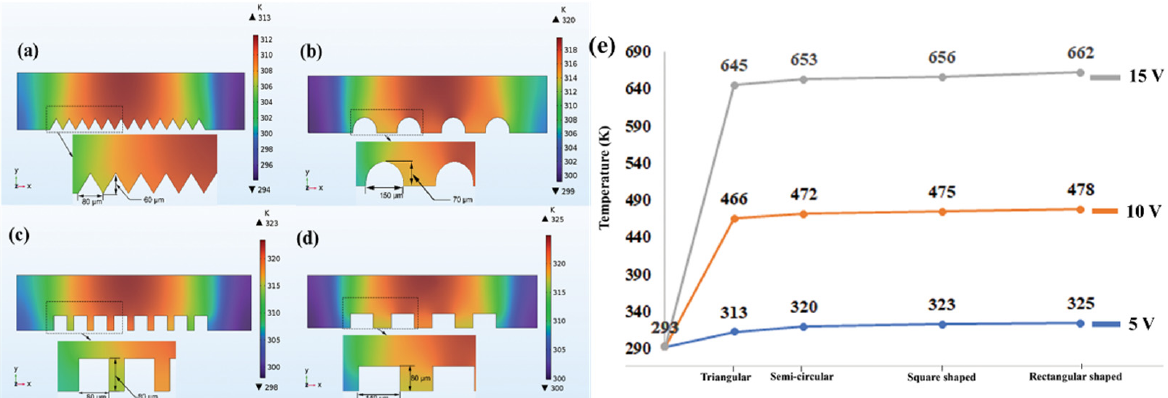
Figure 2. Simulation studies representing contribution of joule heating effects on various electrode shapes. ( a ) Triangular- shaped electrode generates fewer thermal gradients while maintaining reliable separation. The legend graph shows, temperature is around 310 K at the applied potential of 10 V. The insets are magnified views of electrode geometries showing the dimensions of the electrodes. ( b ) With same potential (10 V), semi-circular shape electrodes generate strong electric field leading to high temperature distribution inside the channel (around 322 K). ( c ) The square shaped electrode generates electric field more than semi-circular geometry (above 327 K). ( d ) Rectangular shaped electrode geometry produces even more electric field than square electrode (330 K) at 10 V. ( e ) The comparison plots reveal that triangular electrodes remain attractive even if applied potential is varied between 5 and 15 V, to keep the survival time of cells within threshold as compared to other electrode geometry, however increasing voltage beyond 15 V produces high joule heating (temperature beyond 400 K damages cell).